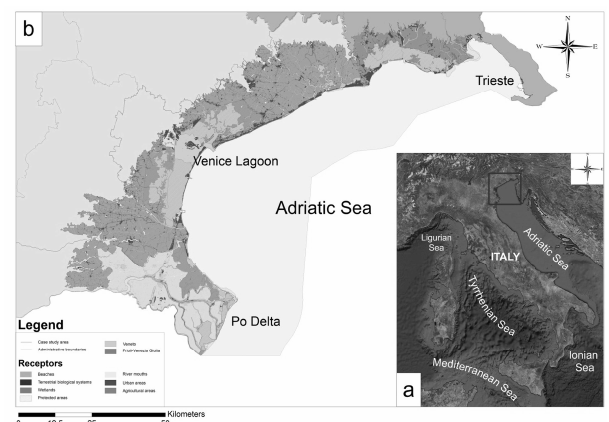
Fig. 1. The case study area: the Northern Adriatic Sea (a) and the coast of the Veneto and Friuli Venezia Giulia regions (Italy) (b) . (Adapted from google maps: